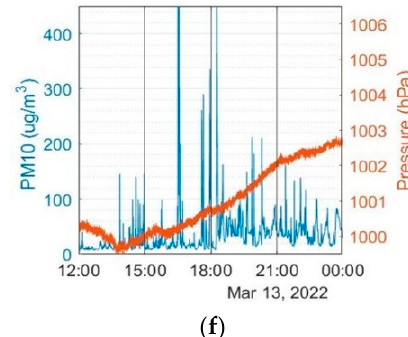
Figure 8. Changes in the measured quantities: PM10 and temperature ( a ) on 12 March 2022, ( b ) 13 March 2022; PM10 and humidity ( c ) on 12 March 2022, ( d ) on 13 March 2022, PM10 and pressure ( e ) on 12 March 2022 and ( f ) 13 March 2022; measured on the balcony.